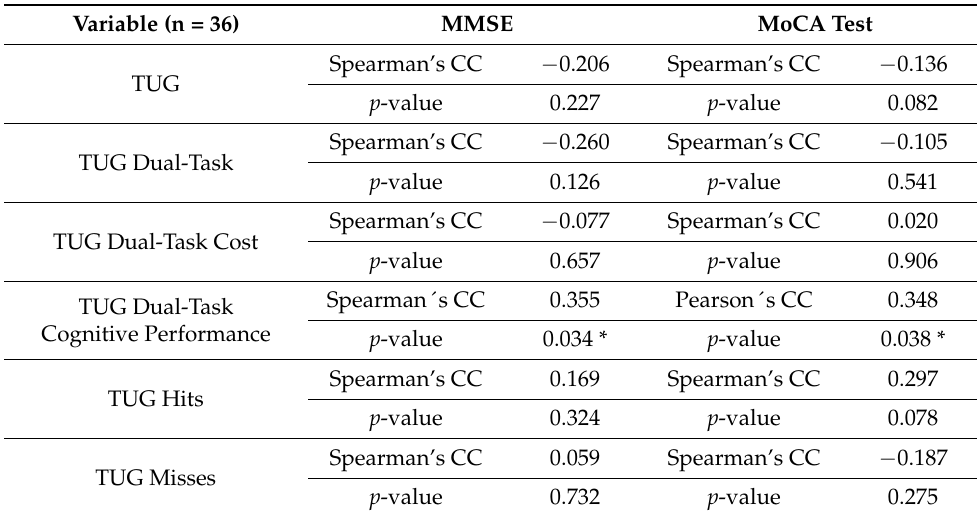
Table 3. Correlations between the TUG test and cognitive